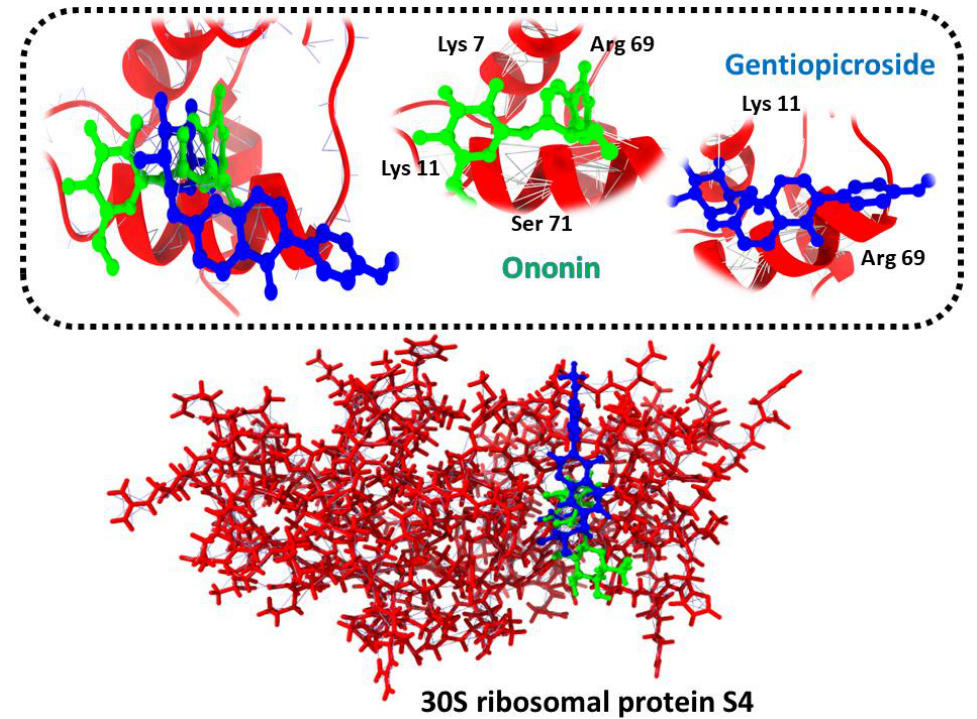
Figure 3. Three-dimensional representation of molecular docking analysis and the interaction of Ononin and Gentiopicroside inhibitors with 30S ribosomal protein S4.